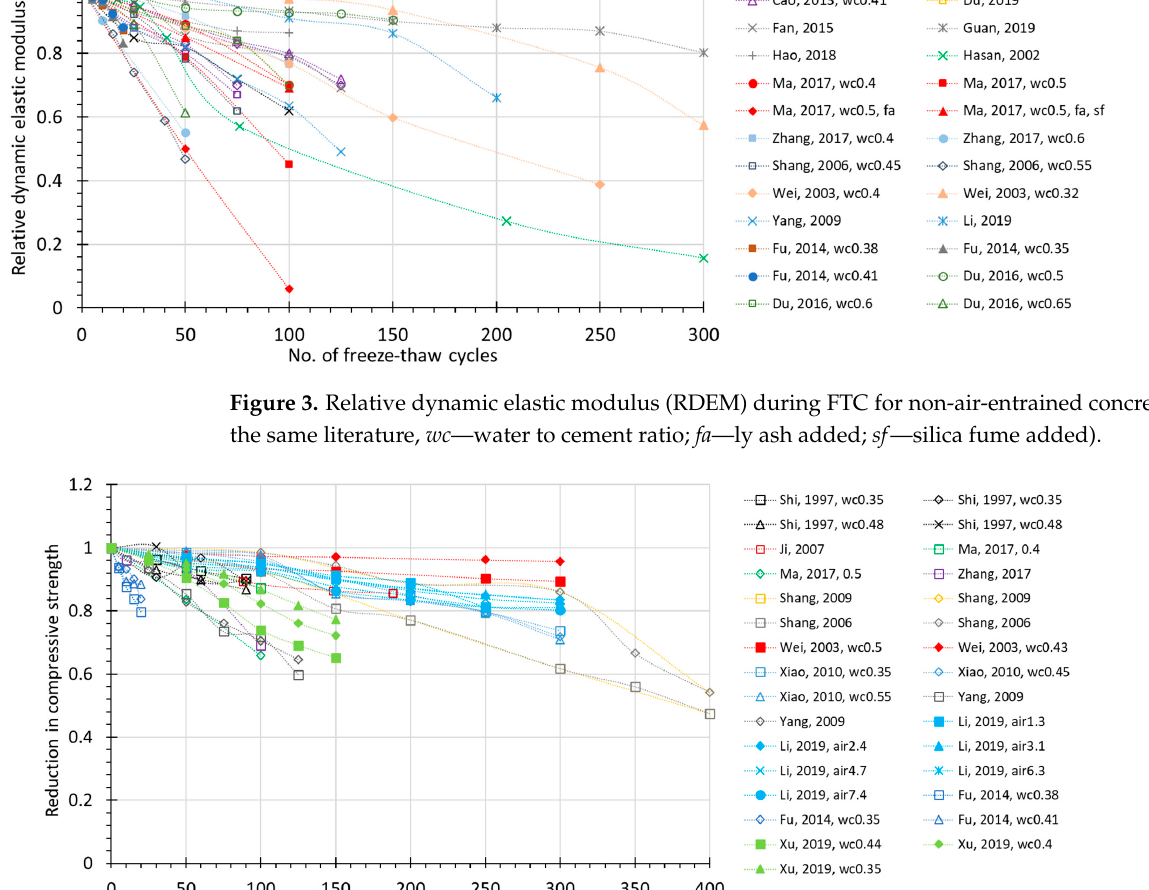
Figure 4. Relative reduction in compressive strength during FTC for air-entrained concrete (for the same literature, wc —water to cement ratio; air —air content).